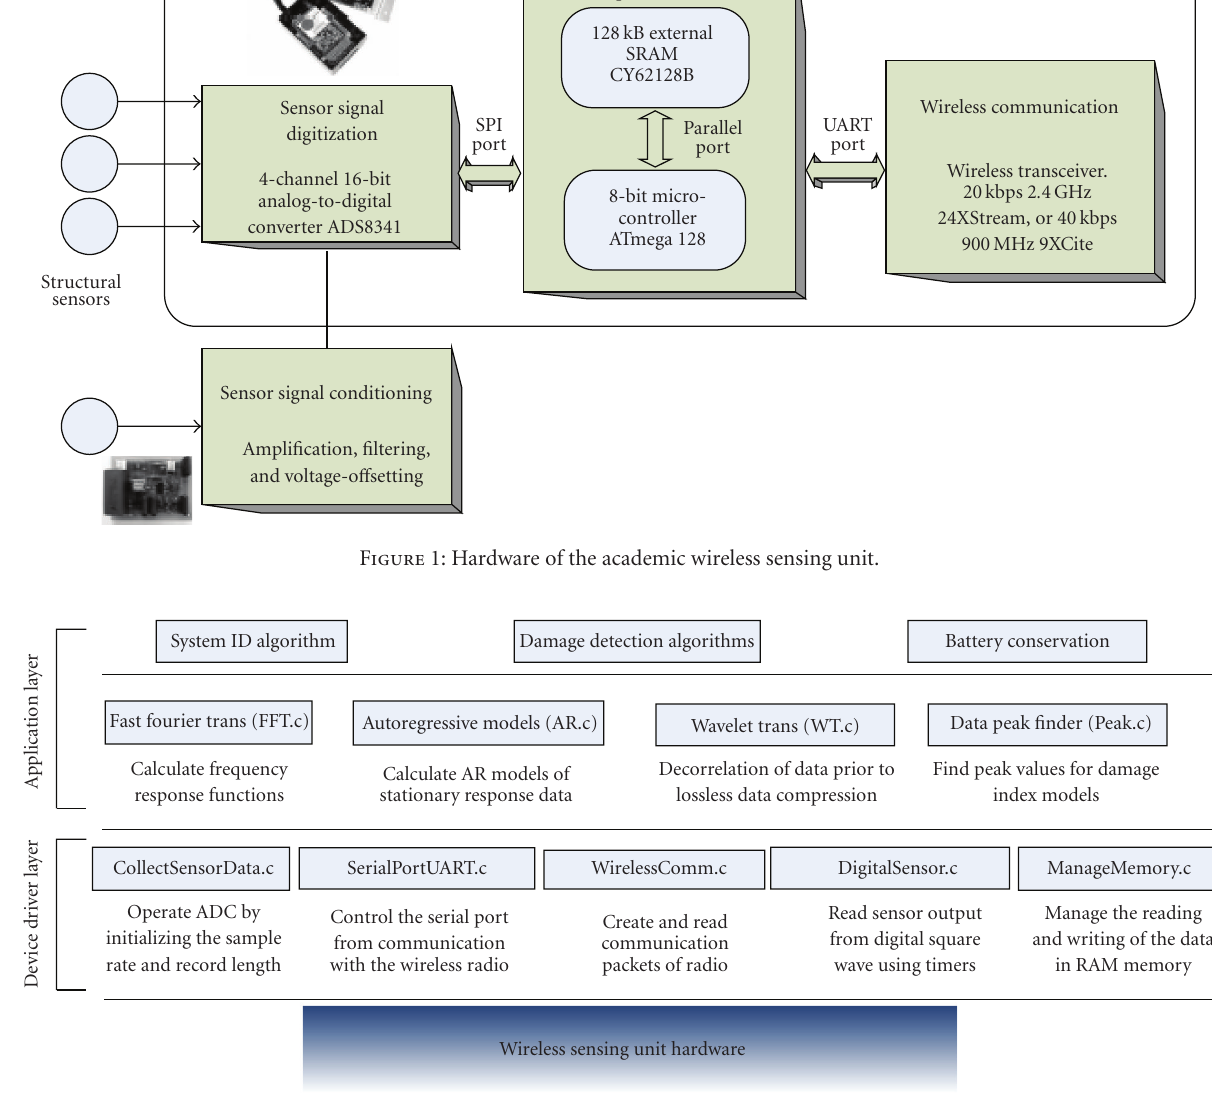
Figure 2: Software Architecture of the academic wireless sensing